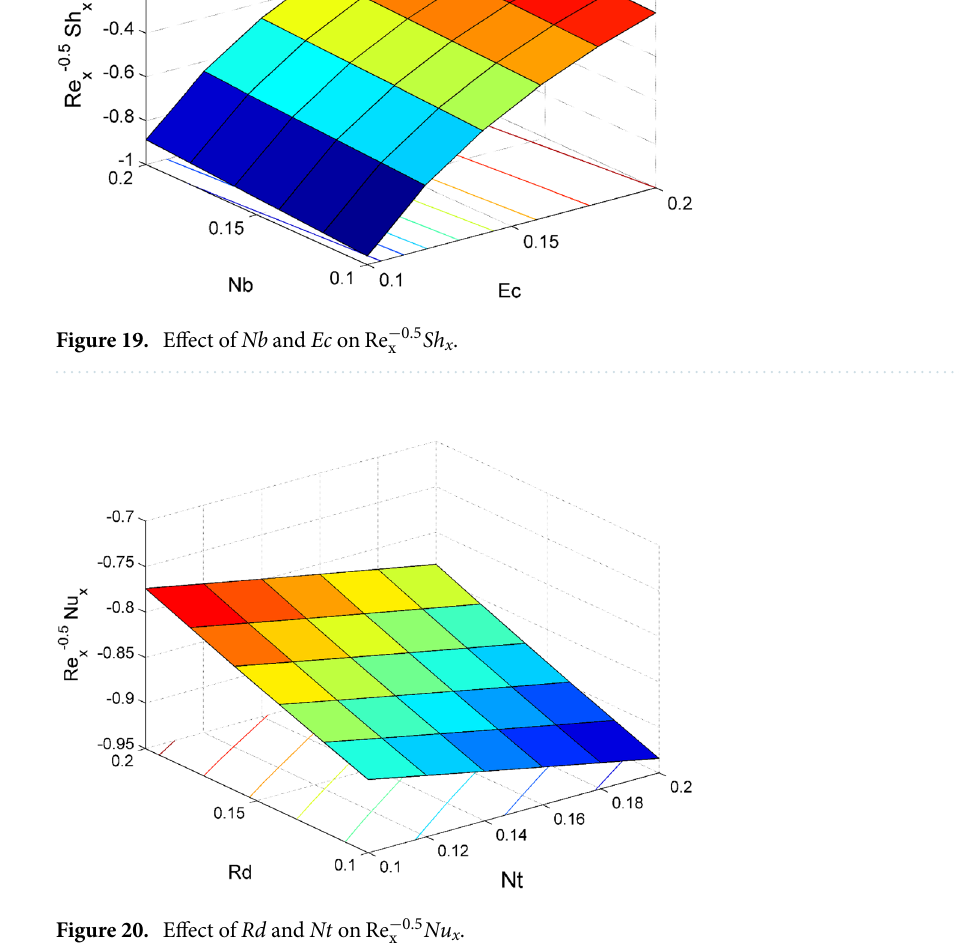
Figure 20. Effect of Rd and Nt on Re − 0.5 x Nu x